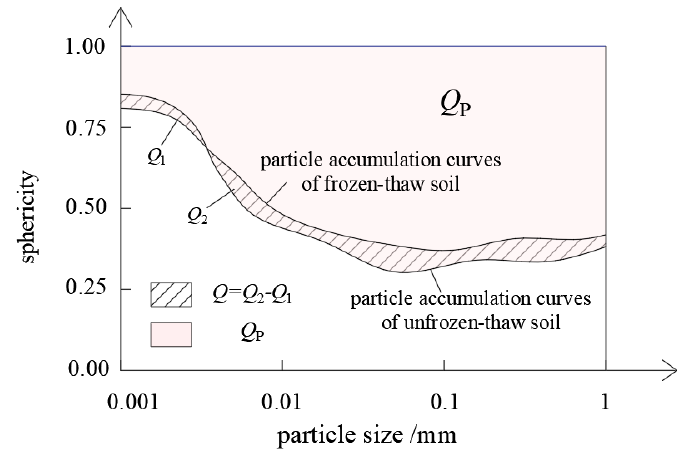
Figure 10. Schematic diagram of total particle shape variation rate.